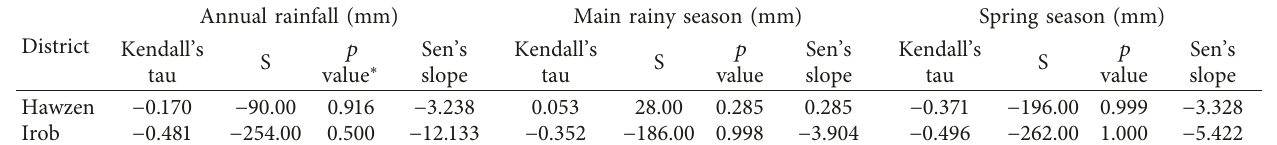
Table 4: Annual and seasonal rainfall trend analysis for Hawzen and Irob in 1983–2015. District